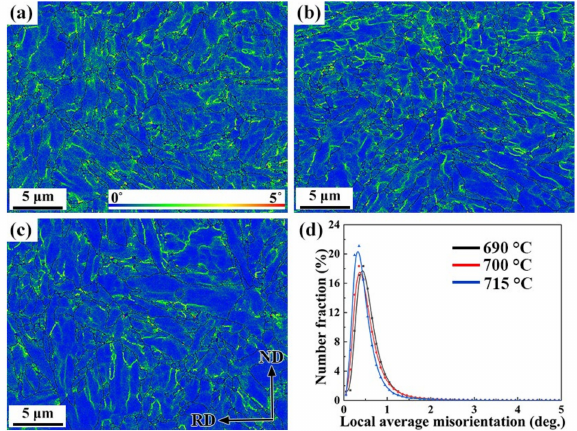
Figure 6. LAM maps of the 0.5Cr0.4Wsteels tempered at ( a ) 690 ◦ C, ( b ) 700 ◦ C, ( c ) 715 ◦ C, and ( d ) LAM vs. number